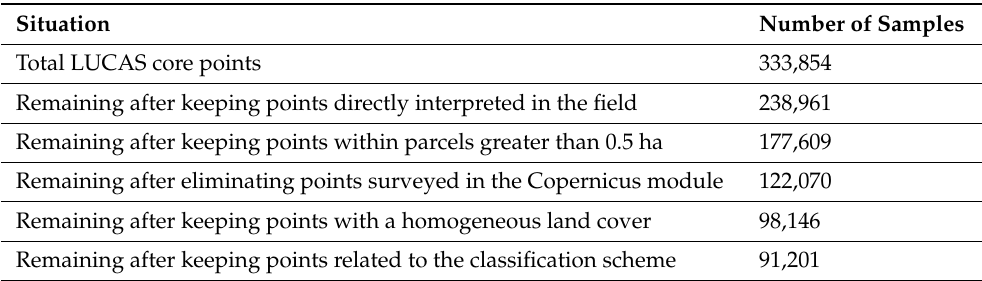
Table 5. Process of extracting validation samples from LUCAS core points.